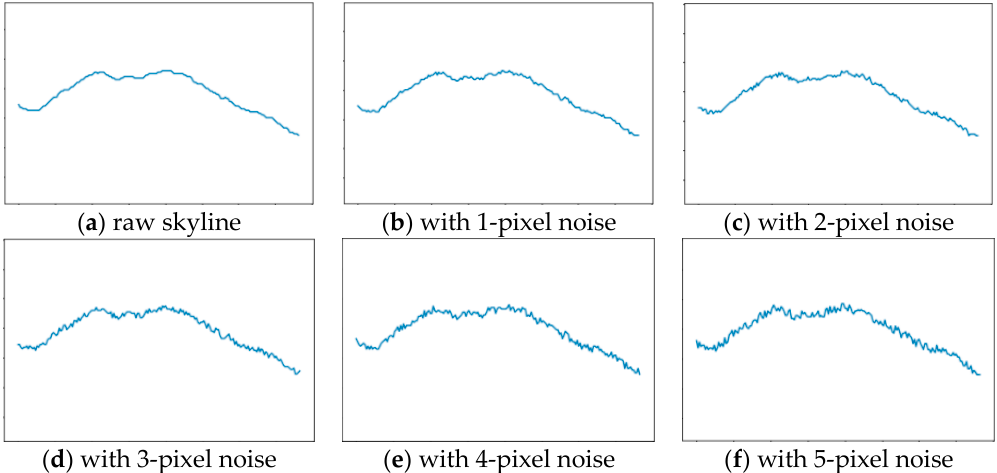
Figure 30. The effect of added noise on a skyline.